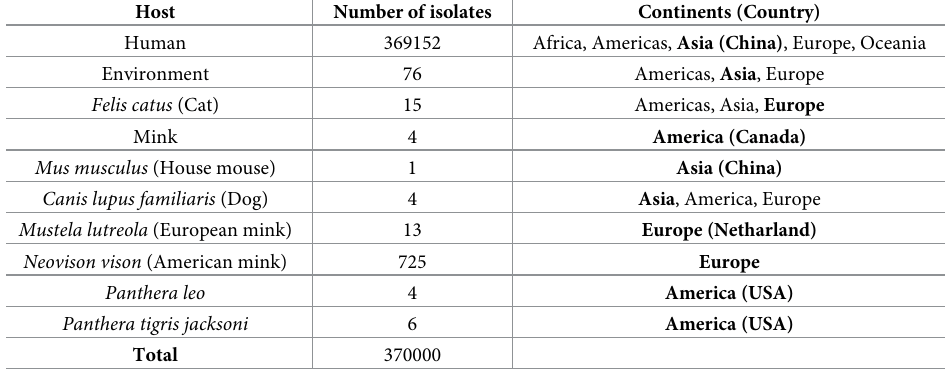
Bold letter indicates the first isolation